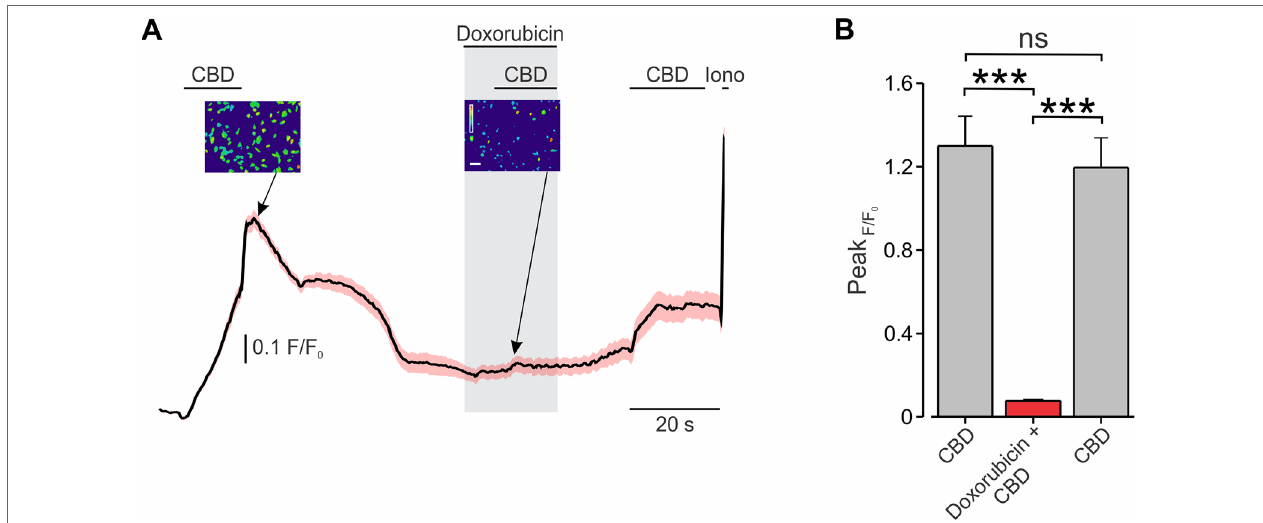
FIGURE 3 | Co-application of CBD with doxorubicin attenuates TRPV2-mediated Ca 2+ entry into BNL1 ME cells. (A) Mean ± SEM of changes in cytosolic [Ca 2+ ] i following bath application of 10 μM CBD in SES, 10 μM CBD in SES containing 1 μM doxorubicin, and 10 μM CBD in after washout of doxorubicin, n = 36 cells. Insets , photomicrographs of blue-green-red pseudocolor radiometry images (taken at the time points indicated by arrows) demonstrated a decrease of F/F 0 after treatment of doxorubicin. Bar, 50 µm. The pseudocolor scale depicts changes in F/F 0 between 0 ( blue ) to 1.5 ( red ). For a positive control of imaging, 1 µM ionomycin (Iono) was added to the bath solution at the end of each experiment. (B) Bar graph depicting mean ± SEM of changes in peak FURA-2AM fluorescence following bath application of 10 μM CBD in SES, 10 μM CBD in SES containing 1 μM doxorubicin, and 10 μM CBD in after washout of doxorubicin. Note a significant decrease in response to CBD when doxorubicin is present in the extracellular solution. Note also that the response to CBD is partially rescued after doxorubicin is washed out. ***—p < 0.001, ns, not significant; RM one-way ANOVA with post hoc Bonferroni, n = 54 cells, from three